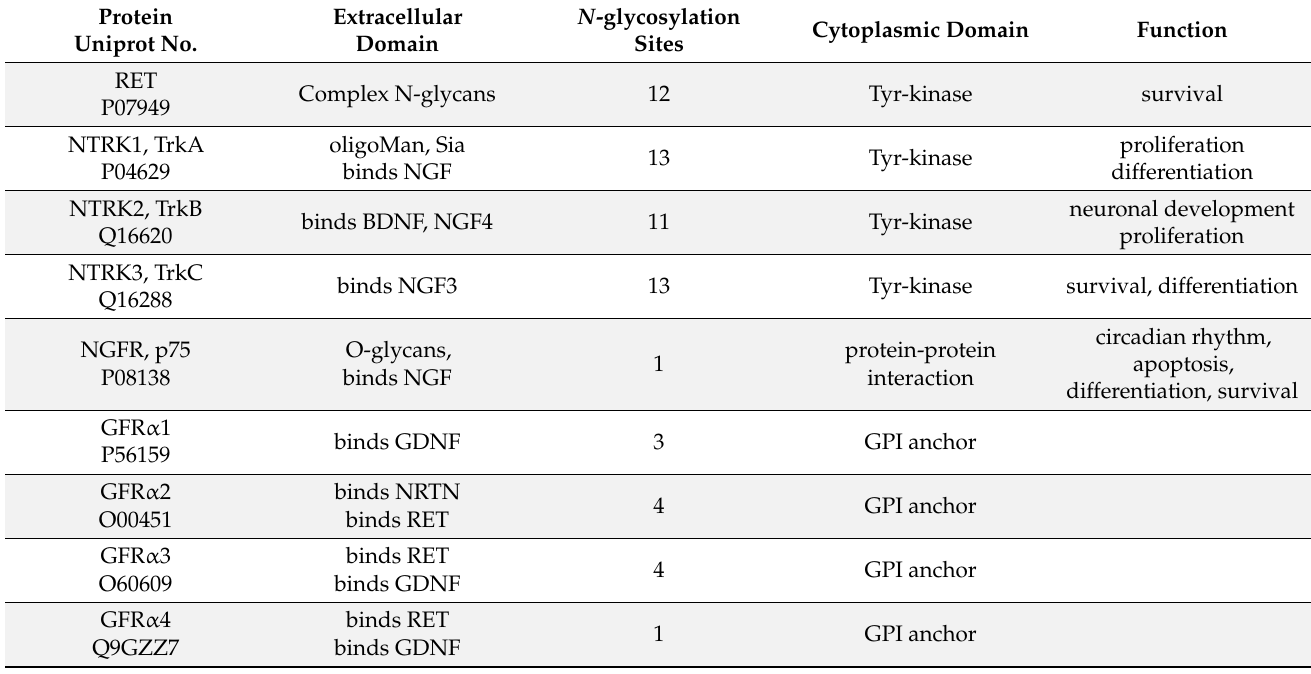
Table 3. Neuronal